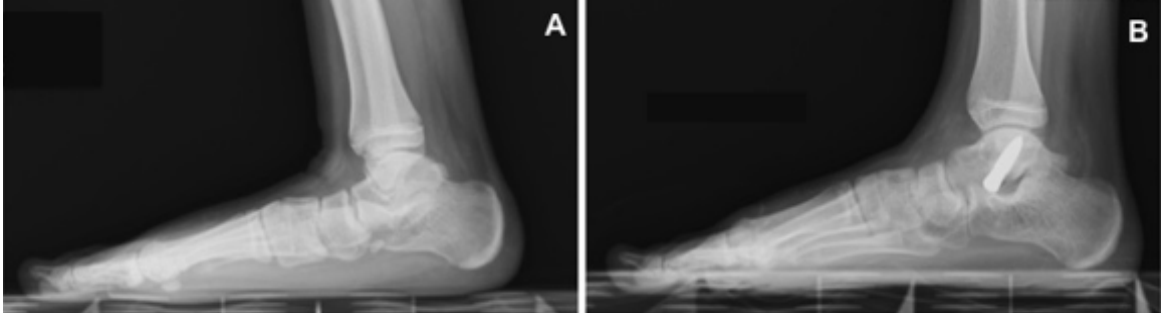
Figure 1. Symptomatic flexible flatfoot (A) treated with an anterograde calcaneo-stop procedure (B).